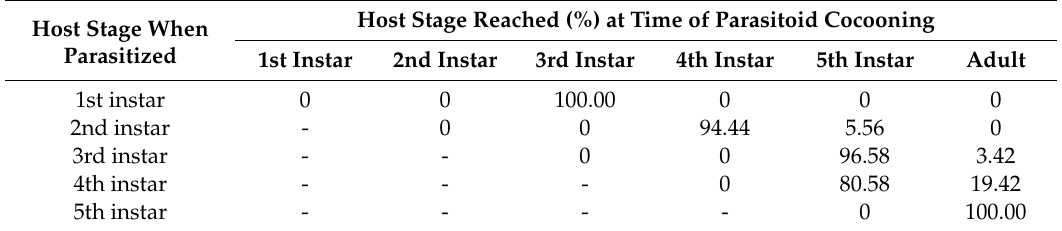
Table 1. Percentages of host stages at the time of Gonatopus flavifemur cocooning.